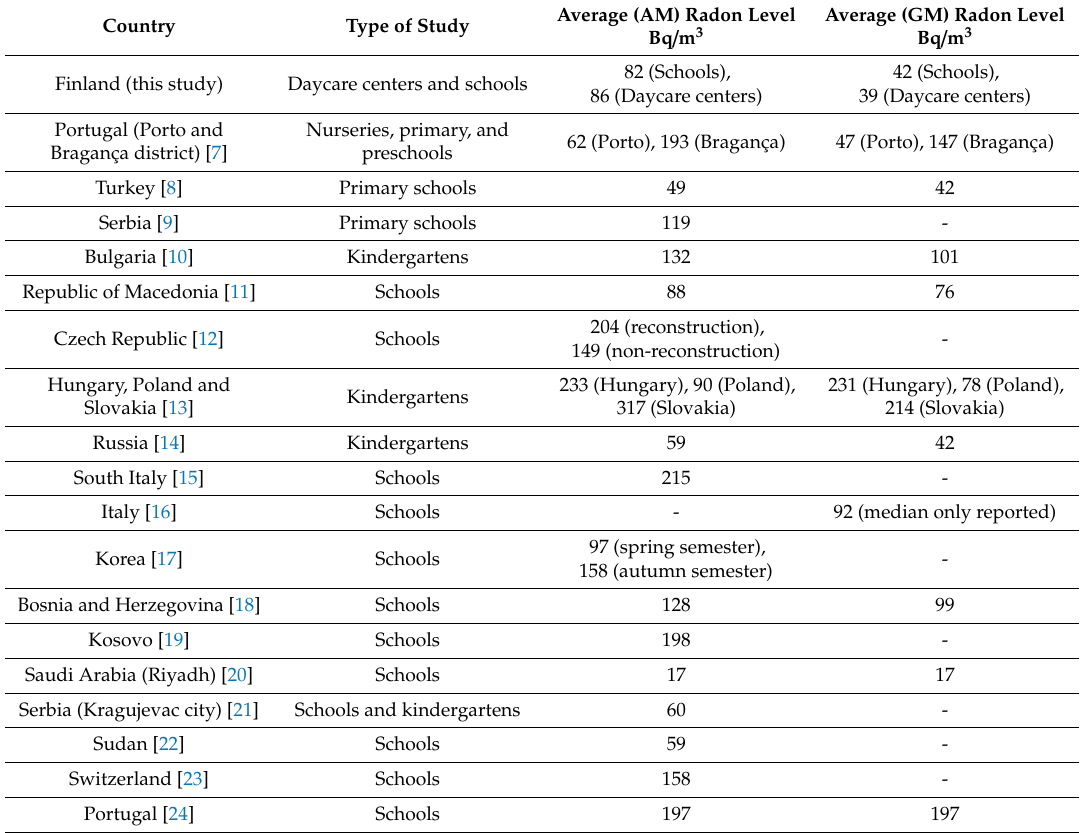
Table 4. Summary of the main results in previous studies conducted in recent years in schools or daycare centers regarding indoor radon measurements. AM = Arithmetic mean, GM = Geometric